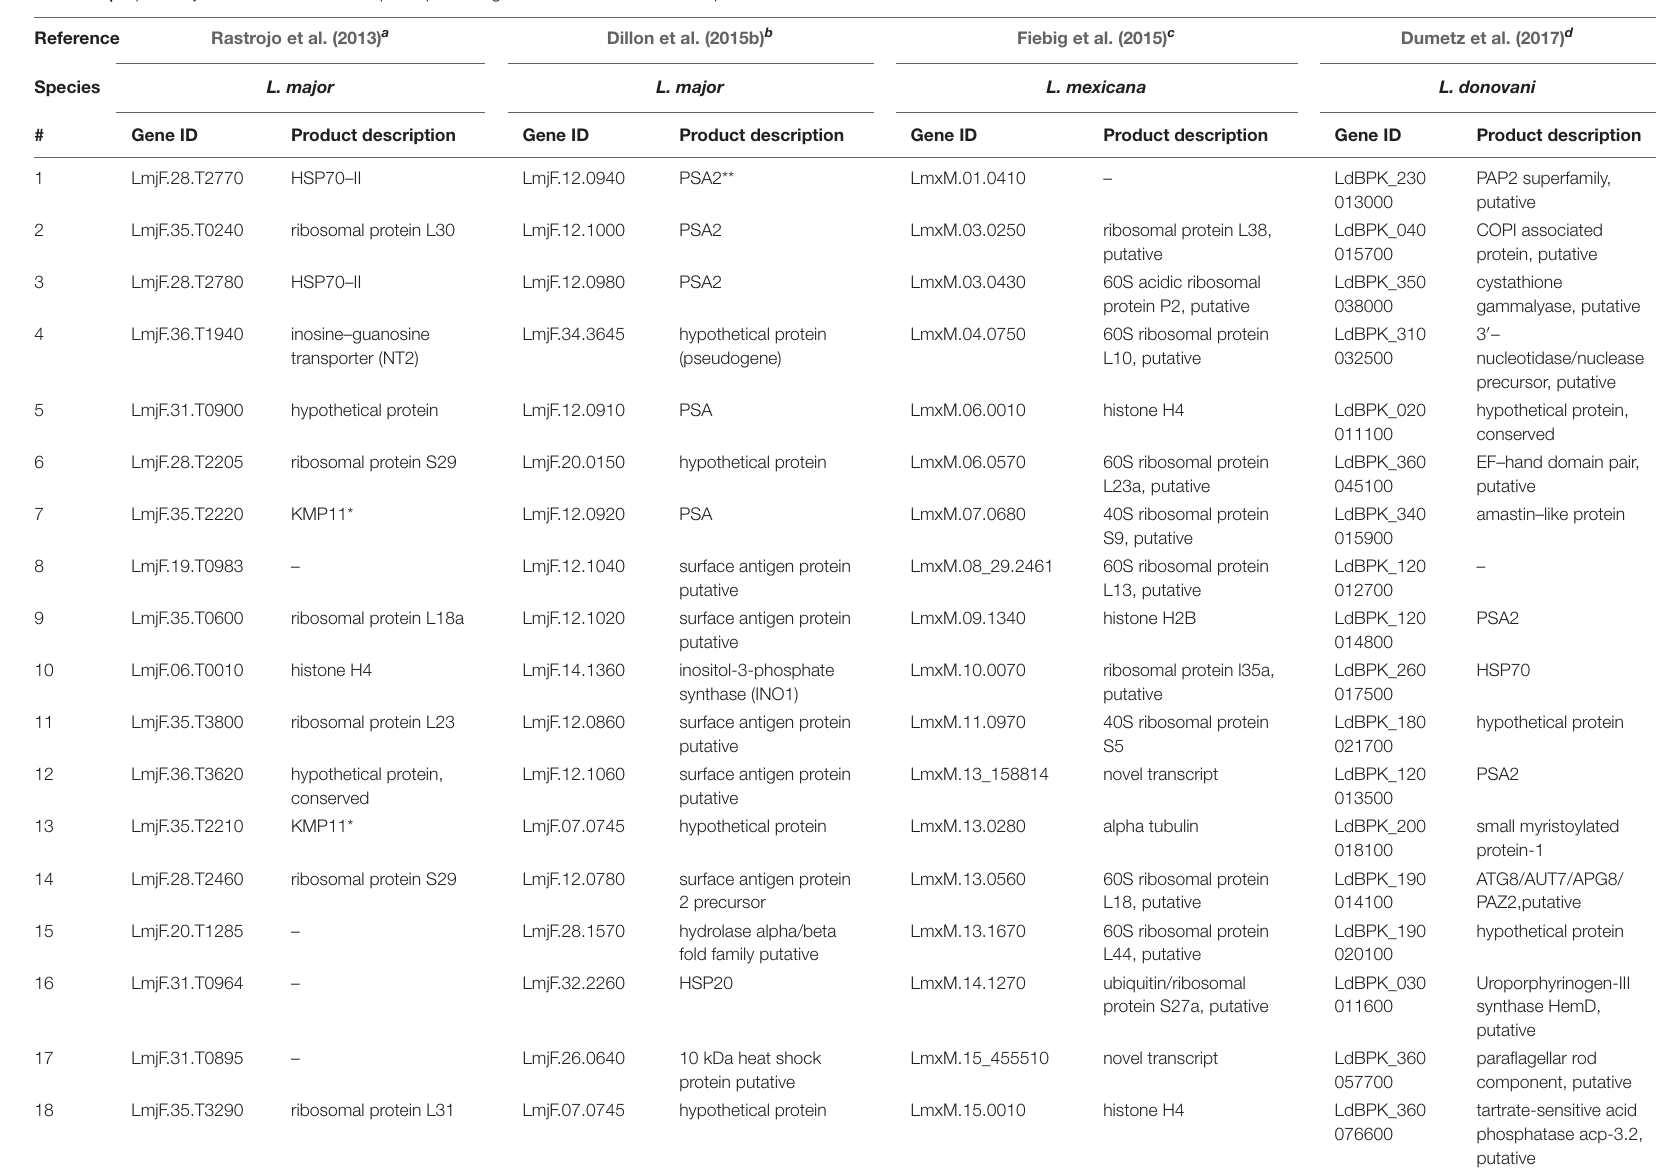
TABLE 1 | Top twenty most abundant transcripts in promastigotes of various Leishmania